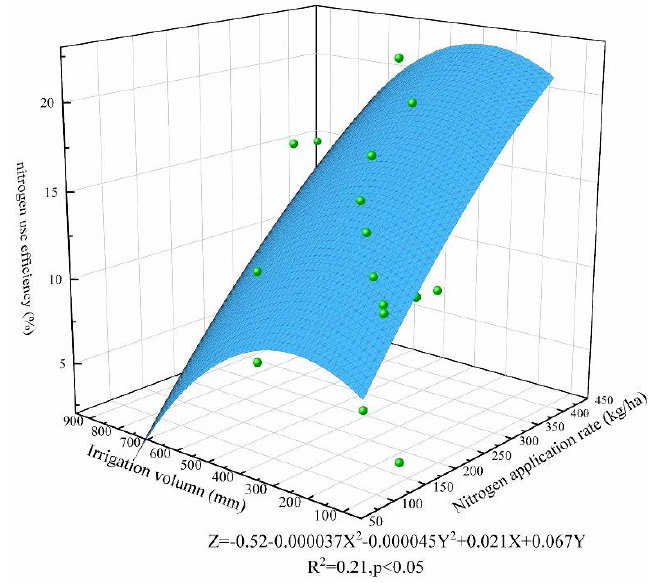
Figure 11. Effect of water – nitrogen coupling on nitrogen use efficiency.